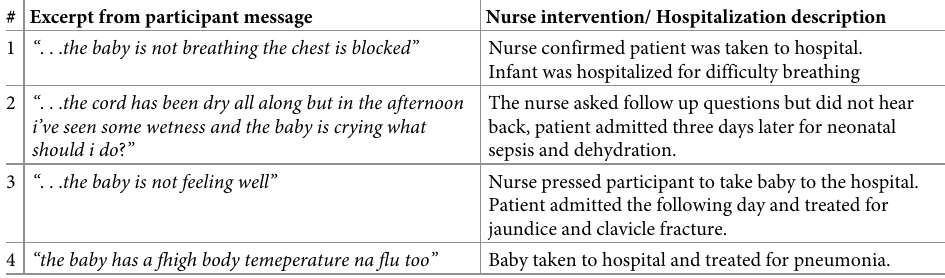
Table 5. Description of SMS interactions describing infant symptoms in week prior to hospitalization.